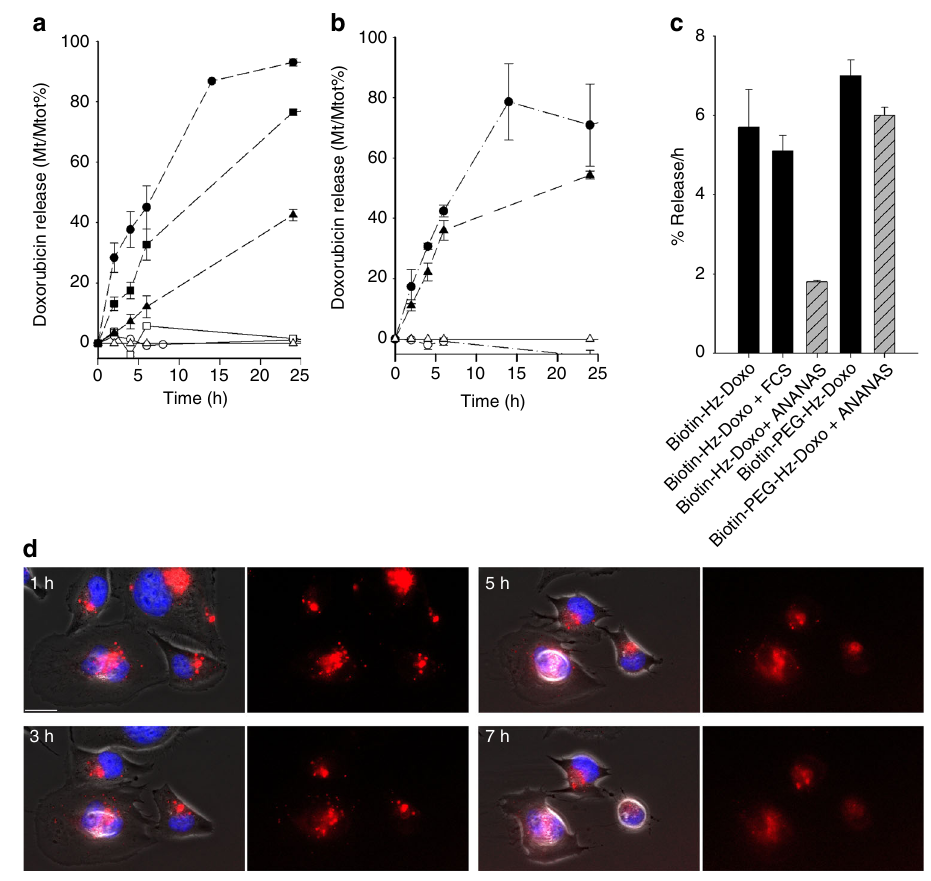
Fig. 5 Drug release in neutral and acidic buffers and upon cell internalization. Kinetics of doxorubicin release from a biotin-Hz-doxorubicin, b biotin-PEG- Hz-doxorubicin at pH 7.4 (open symbols) or 5.0 (full symbols) in protein-free buffers (circle symbols), and in presence of 10% fetal calf serum (square symbols) or ANANAS (triangle symbols). c Hourly release rates (see also Supplementary Table 3) extrapolated from the linear part of curves in a and b ; Data were generated at 37 °C and the results are expressed as % of total release. Release experiments were carried out in duplicates and data are presented as the mean ± standard deviation (S.D). d Extracts of live fl uorescence microscopy images of MDA-MB-231 cells exposed to ANANAS-Hz- doxorubicin-cetux10 (36 µ g/mL) for 1-h at 37 °C, then fl uxed in fl ow a chamber to remove unbound nanoparticles and imaged for up to 7 h; the right panels show the doxorubicin-related (red) signal, the corresponding left panels show the red doxorubicin images superimposed with the phase contrast and nuclei (blue, Hoechst) ones. Size bar 20 μ m. Along the experiment, the doxorubicin-related red signal is initially concentrated in cytoplasmic vesicles compartments, then it starts diffusing out from there and concentrating in the cell nuclei. The entire live imaging Video is available in